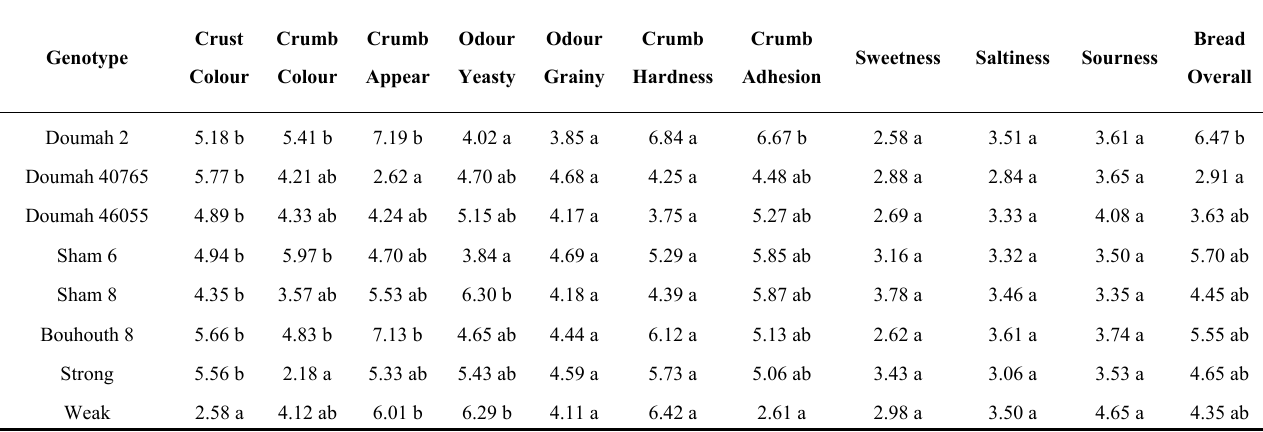
Table 9. Bread sensory